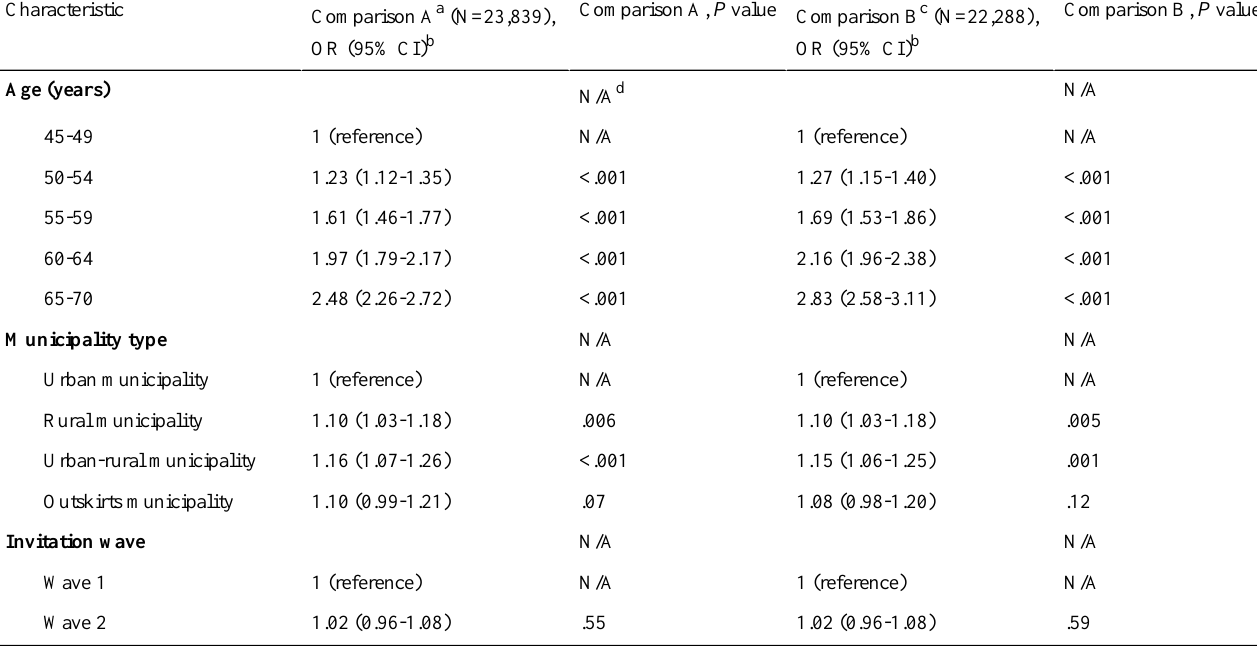
Table 3. Comparison of responders and nonresponders according to age and dwelling adjusted for age, municipality, and